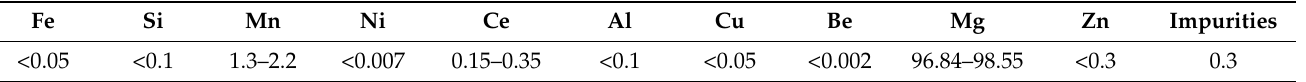
Table 1. Composition of MA8 alloy in mass%